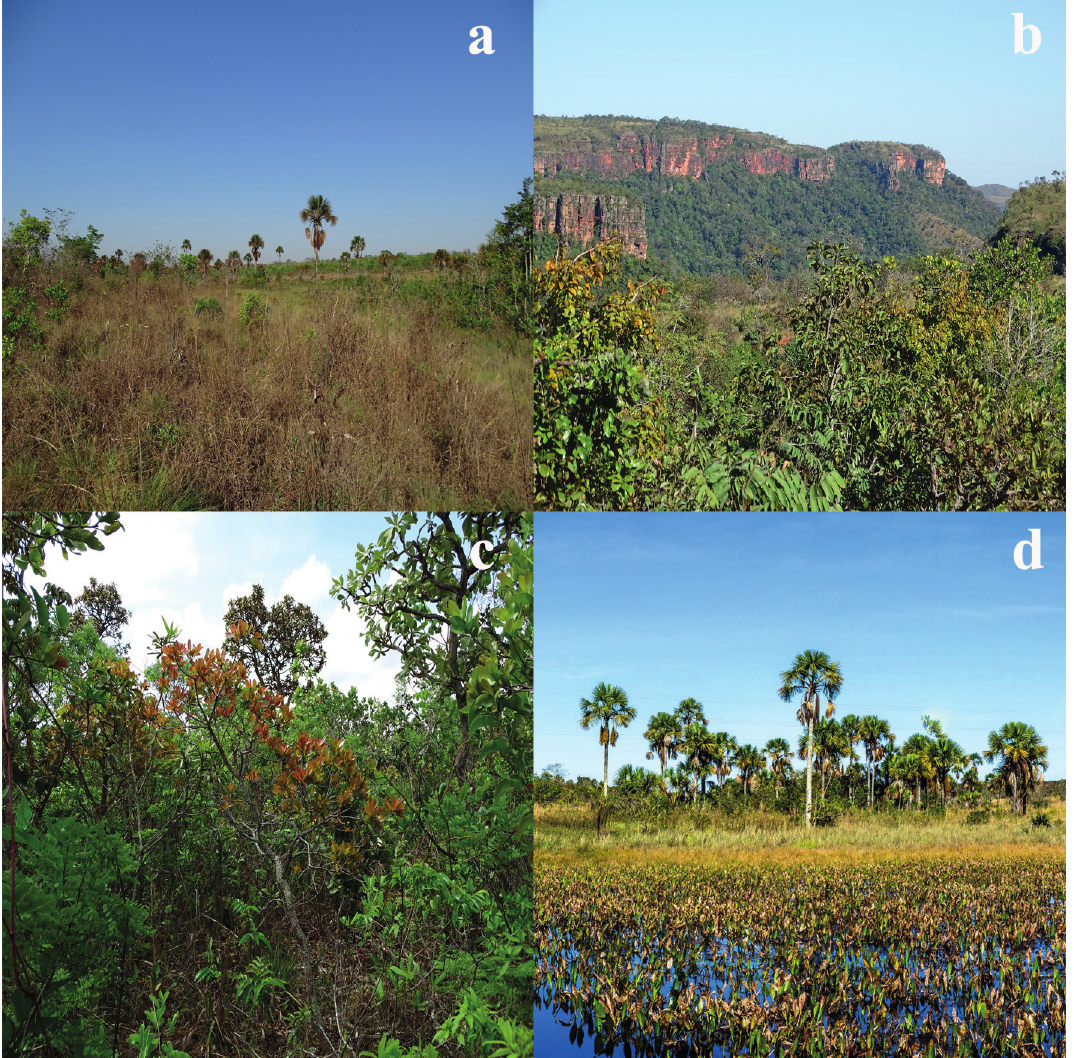
Figure 1 - The most common physiognomies of the Brazilian tropical savannas: a – Open cerrado – opened areas of large fields, in some cases acting as an ecotone between cerrado and veredas; b – The cerradão, dry forest – tall trees in areas of more compacted soil; c – The cerrado sensu stricto – shrubs and small tress in a sand soil area; d – The veredas or palm tree wetlands – in the lower parts of landscape, occurs in high humidity and clay